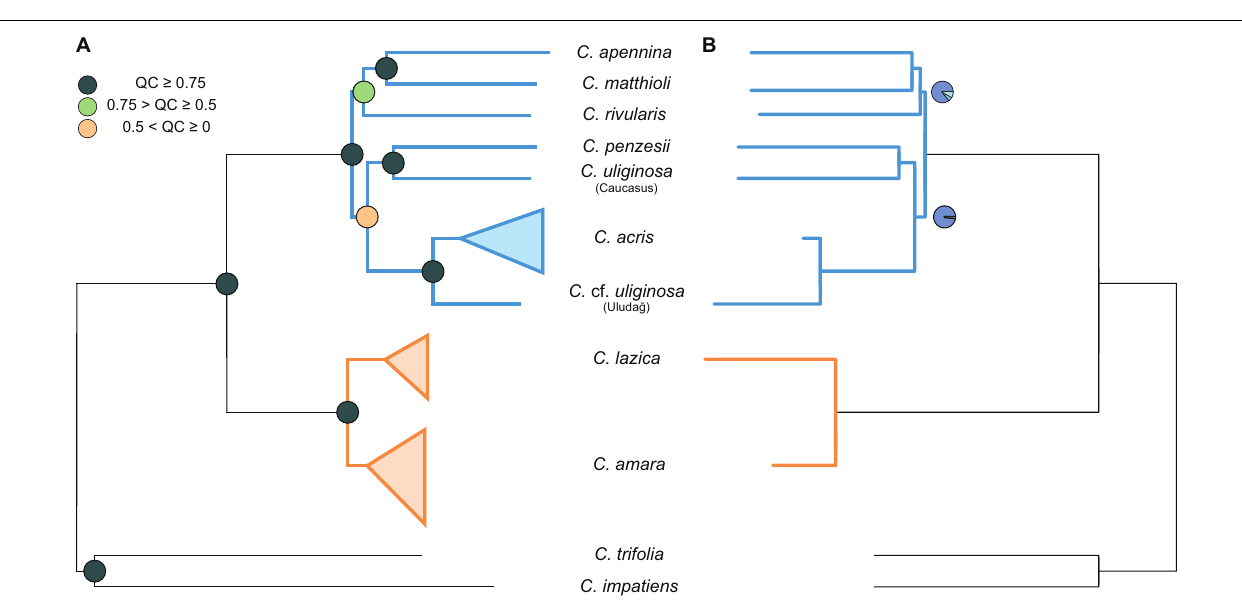
FIGURE 3 | Phylogenetic trees inferred from the complete dataset of 1,168 nuclear genes, based on consensus supercontig sequences of diploid Cardamine accessions. Orange color is used for the clades and branches of the Cardamine amara group, whereas blue is used for the remaining diploids resolved in the sister position. (A) Maximum likelihood tree inferred in RAxML-NG from the concatenated genes. Multiple individuals per species are shown collapsed (see Supplementary Figure 1 for the fully labeled version of the tree including bootstrap support). Branch support is indicated by quartet concordance (QC) values (colored circles in the nodes). (B) Species tree inferred in ASTRAL-III. Branch support is indicated by pie charts, depicting three local posterior probabilities for the given branch (dark blue for the main topology as resolved here and light blue for the alternative ones; not shown for the fully supported branches when the local posterior probability for the present topology equals